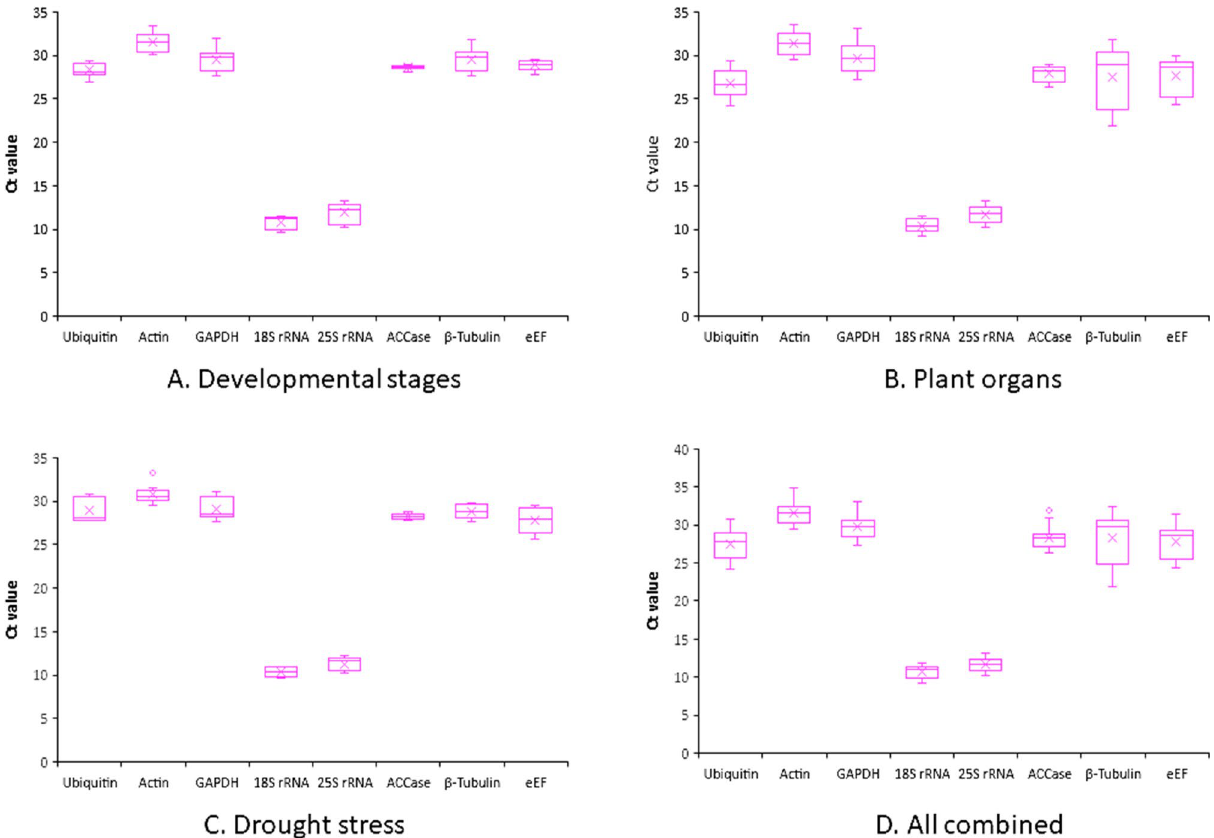
Figure 1. Expression levels of the eight candidate genes. Ct values obtained from three developmental stages (2nd, 3rd and 4th leaves), two different plant organs (shoots and leaves) and abiotic stress (drought stress) were compared and